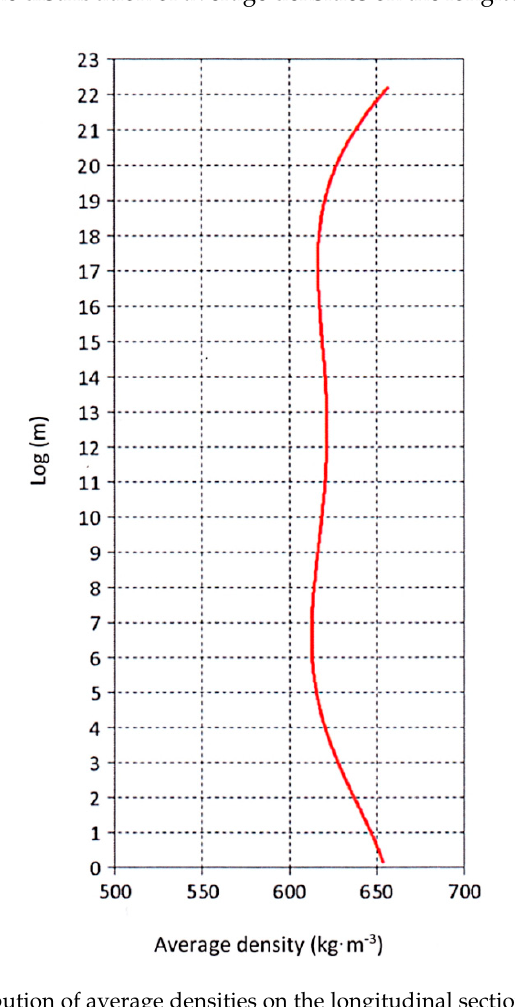
Figure 6. Distribution of average densities on the longitudinal section of a birch log.